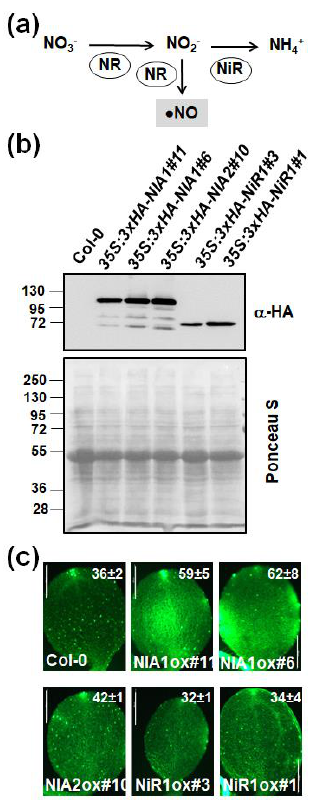
Figure 4. Levels of protein and endogenous NO content in plants overexpressing HA-tagged NIA1, NIA2, and NiR1 proteins. ( a ) Scheme showing nitrate assimilation pathway catalyzed by nitrate reductases (NR) and nitrite reductase (NiR) and the alternative reduction of nitrite to NO. ( b ) Levels of HA-tagged proteins were detected by Western blot with an anti-HA antibody coupled to horseradish peroxidase. Loading control is shown with Ponceau S stained membranes. The position of protein size markers (kDa) is shown at the left side. ( c ) Endogenous levels of NO in cotyledons of the indicated genotype after treatment with DAF-FM diacetate. Values are the mean ± standard error of three independent replicates. Scale bars correspond to 500 μm.